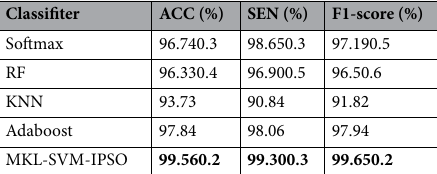
Table 9. Recognition performance of different classifiers. Significant values are in bold.